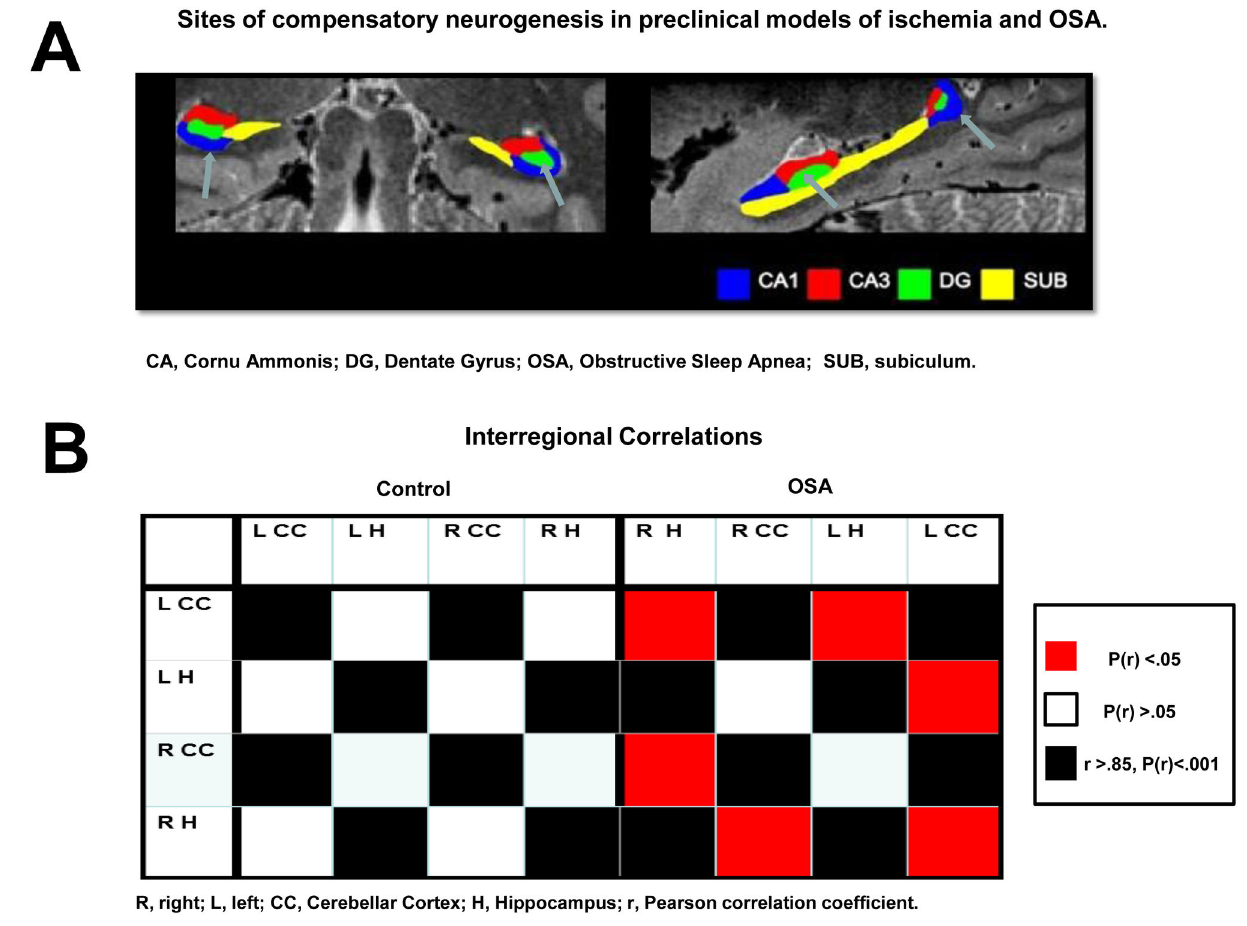
Figure 1. Sites of compensatory neurogenesis in preclinical models of ischemia and OSA. A ) Dentate gyrus and CA1(arrows) support neurogenesis in animal models of ischemia and OSA [29,31,33]; human hippocampal subfields are shown (coronal/sagittal planes), adapted with permission from [72]. B ) Potential aberrant connectivity between the hippocampus and cerebellum in OSA